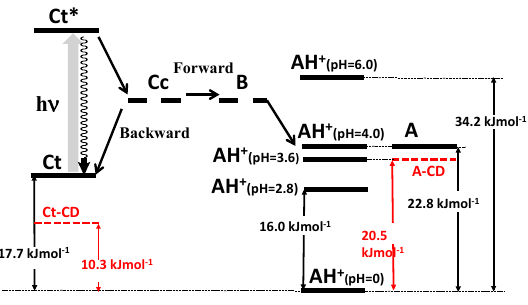
Scheme 15. Energy level diagram of 4 ′ ,7-dihydroxyflavylium in the absence (black color) and presence of β -cyclodextrin 9 mM (red color). With permission of ACS from reference [29].